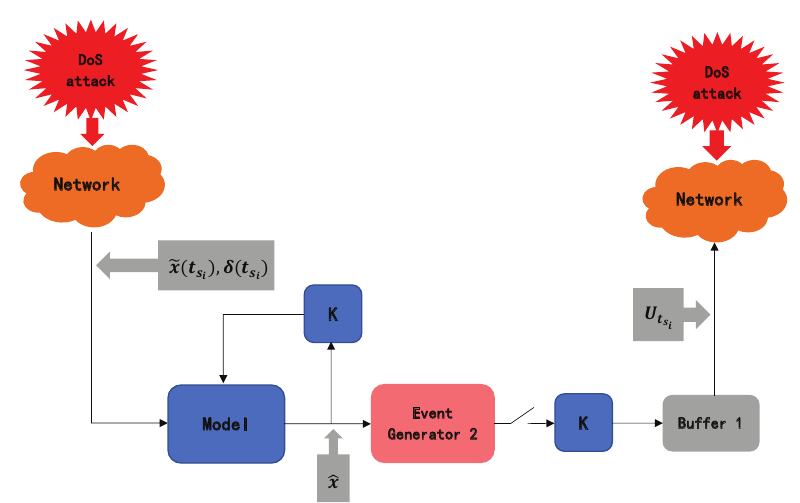
Figure 4. The block diagram of the predictive control